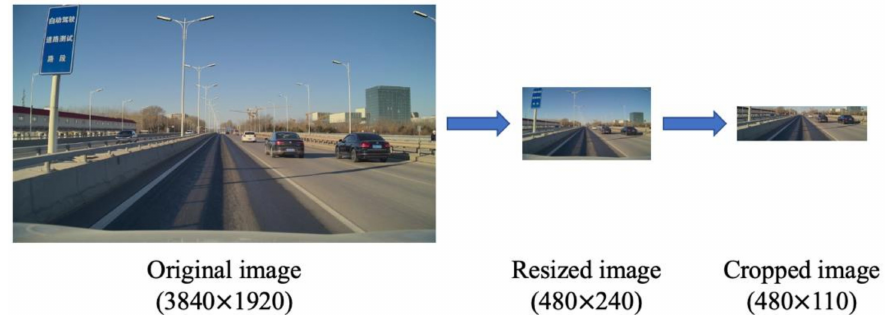
Figure 6. Image pre-processing